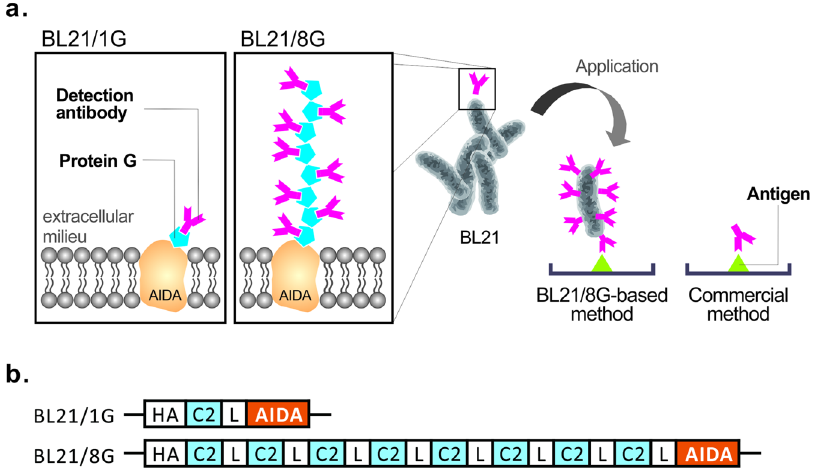
Figure 1. Poly-protein G-expressing BL21 bacteria. ( a ) Strategy for the non-covalent modification of detection antibodies to the single protein G C2 domain-expressing bacteria (BL21/1G) or the eight tandemly repeated C2 domain-expressing bacteria (BL21/8G). ( b ) Schematic representation of the gene construction of the protein G-expressing plasmids (1G and 8G). The construction includes, from N to C termini, an HA epitope tag, a single or eight tandemly repeated protein G C2 domain fragment (C2), a (GGGSG)3 linker (L), and an